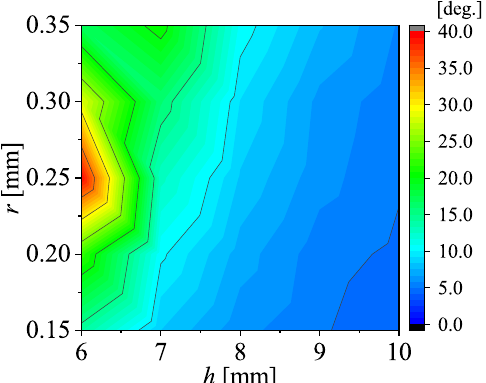
Fig. 10. Phase shift difference by subtracting phase shift between crossover of 10% and 100% at 2GHz from that at 1.5GHz when h and r are varied.